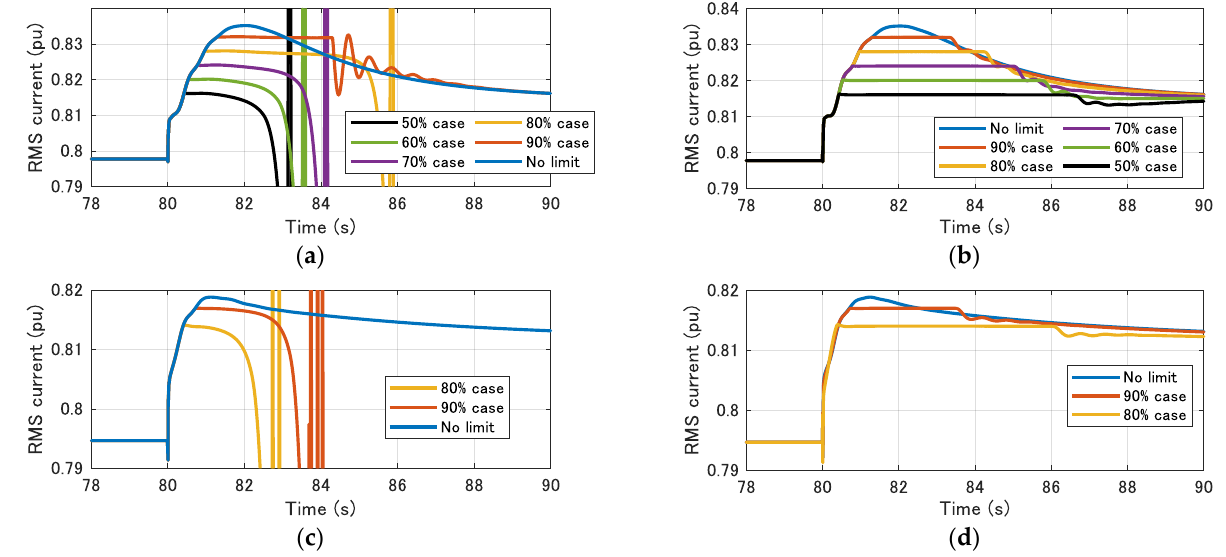
Figure 10. IBR output current in per-unit value. ( a ) #3-GFM-L, ( b ) #3-GFMpro-L, ( c ) #3-GFM-H, and ( d ) #3-GFMpro-H.